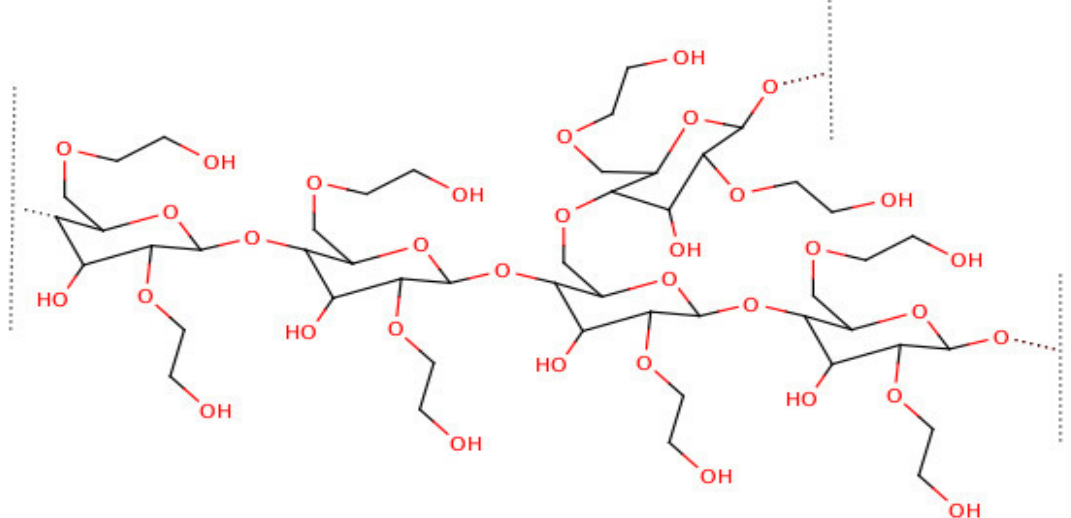
Figure 5. Schematic representation of hydroxyethyl-starch